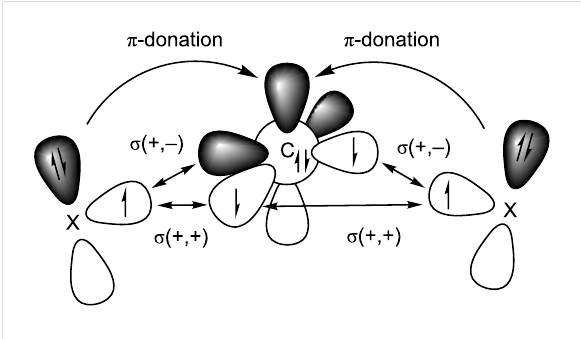
Scheme 2: Schematic view of the major orbital interactions between a carbon atom in the 3 P electronic ground state with the